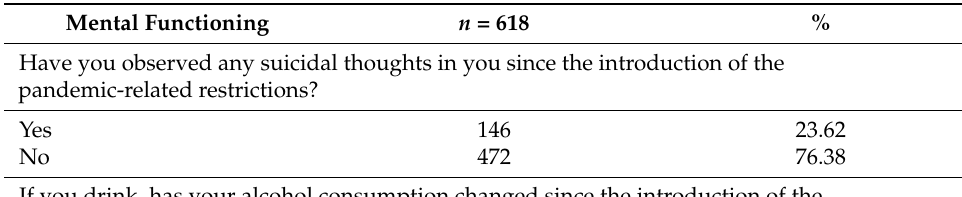
Table 3. Mental functioning during the epidemic.